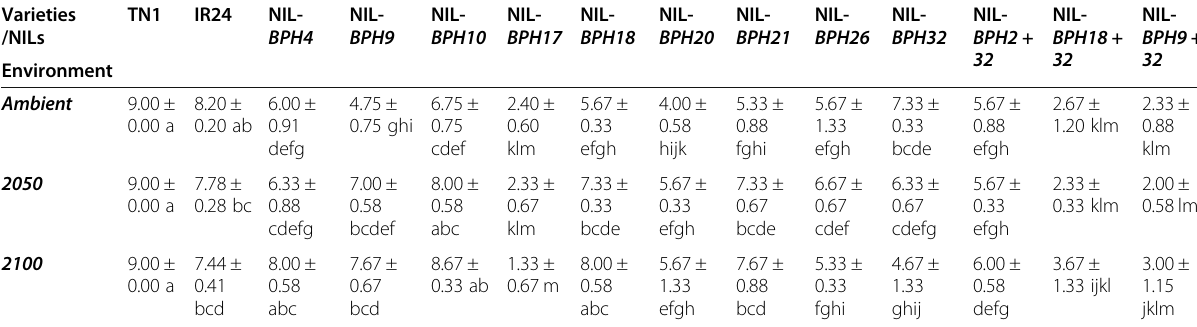
Table 2 The SSST of NILs under three different environments Varieties /NILs